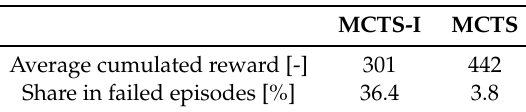
Table 4. Statistic performance of Monte Carlo tree search (MCTS) with 0.1 s step size and MCTS-I with 0.5 s step